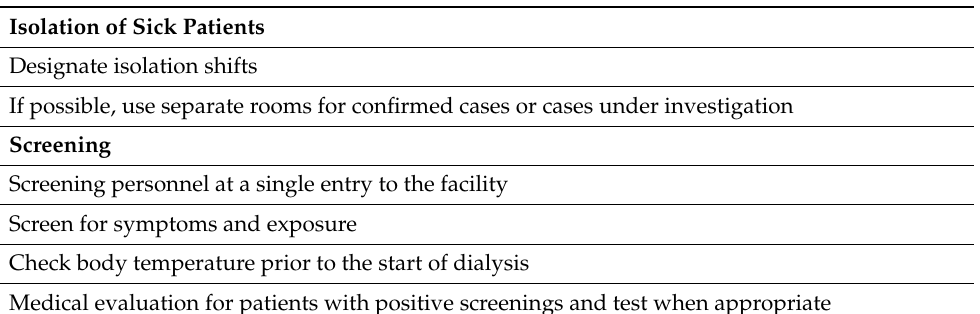
Table 3. Strategies aiming to mitigate spread of SARS-CoV2 in dialysis